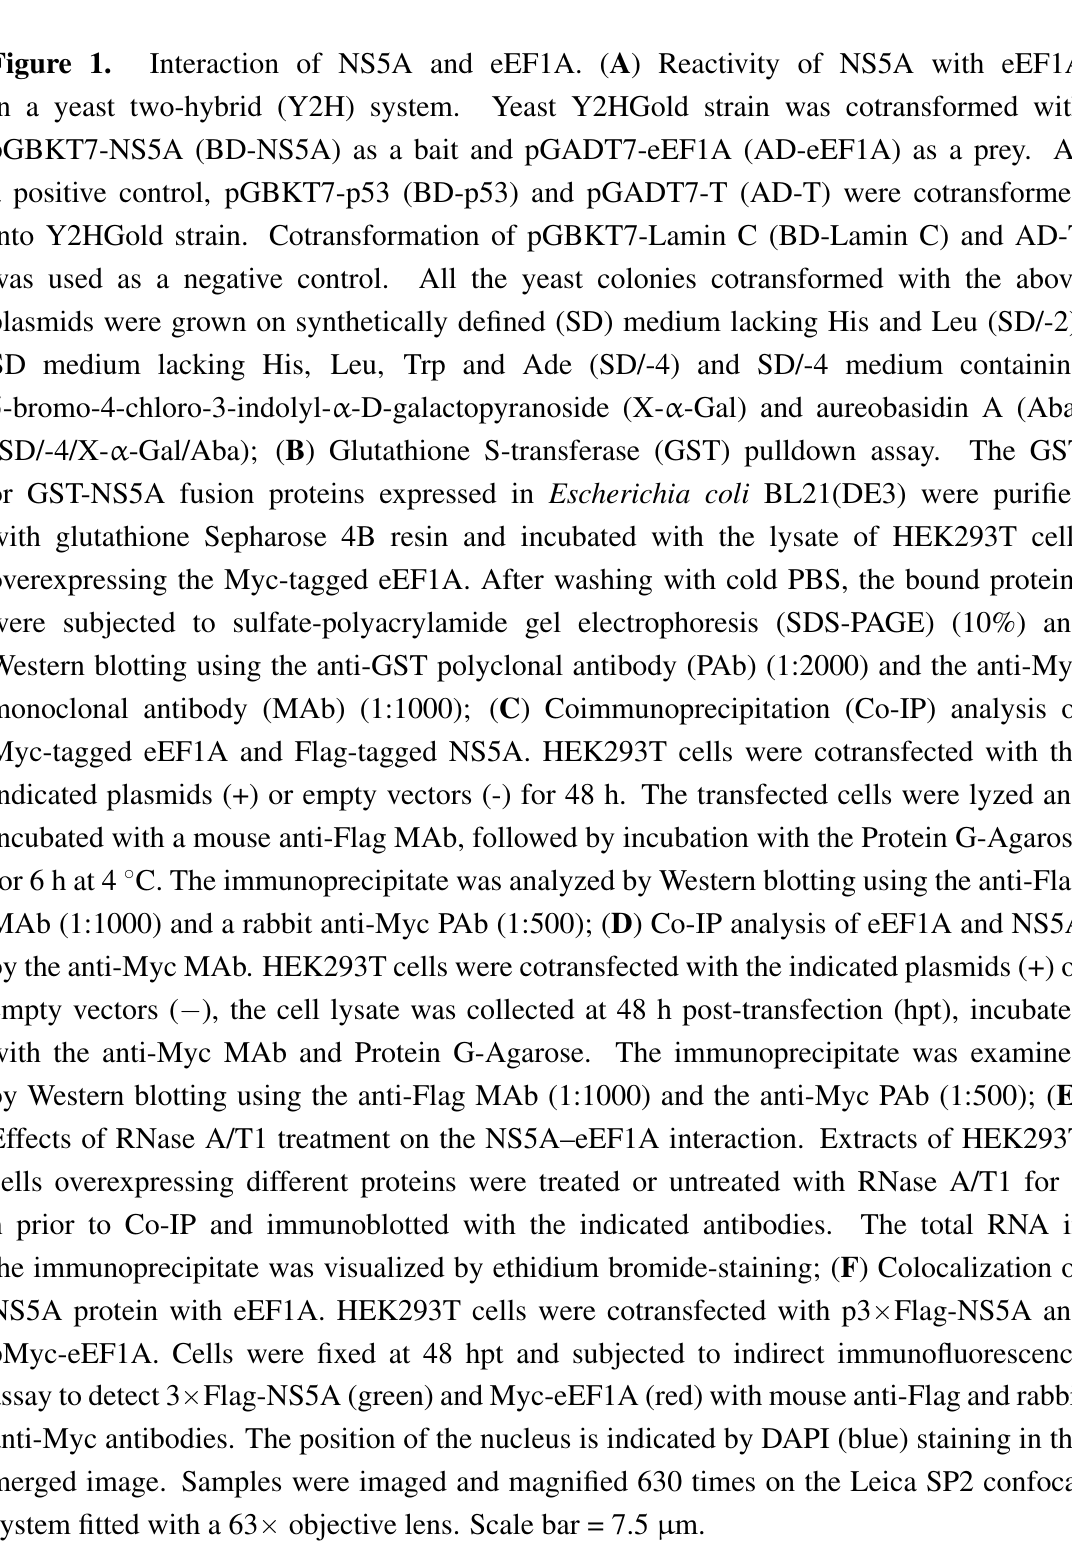
Figure 1. Interaction of NS5A and eEF1A. ( A ) Reactivity of NS5A with eEF1A in a yeast two-hybrid (Y2H) system. Yeast Y2HGold strain was cotransformed